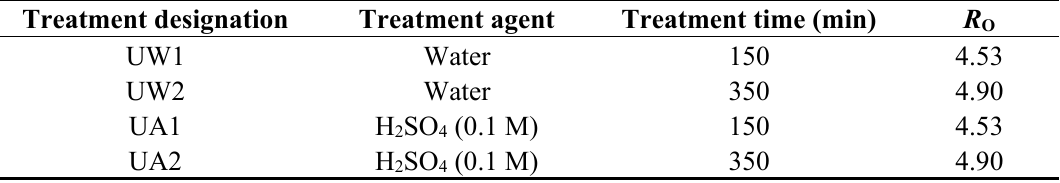
Table 7. Treatment conditions